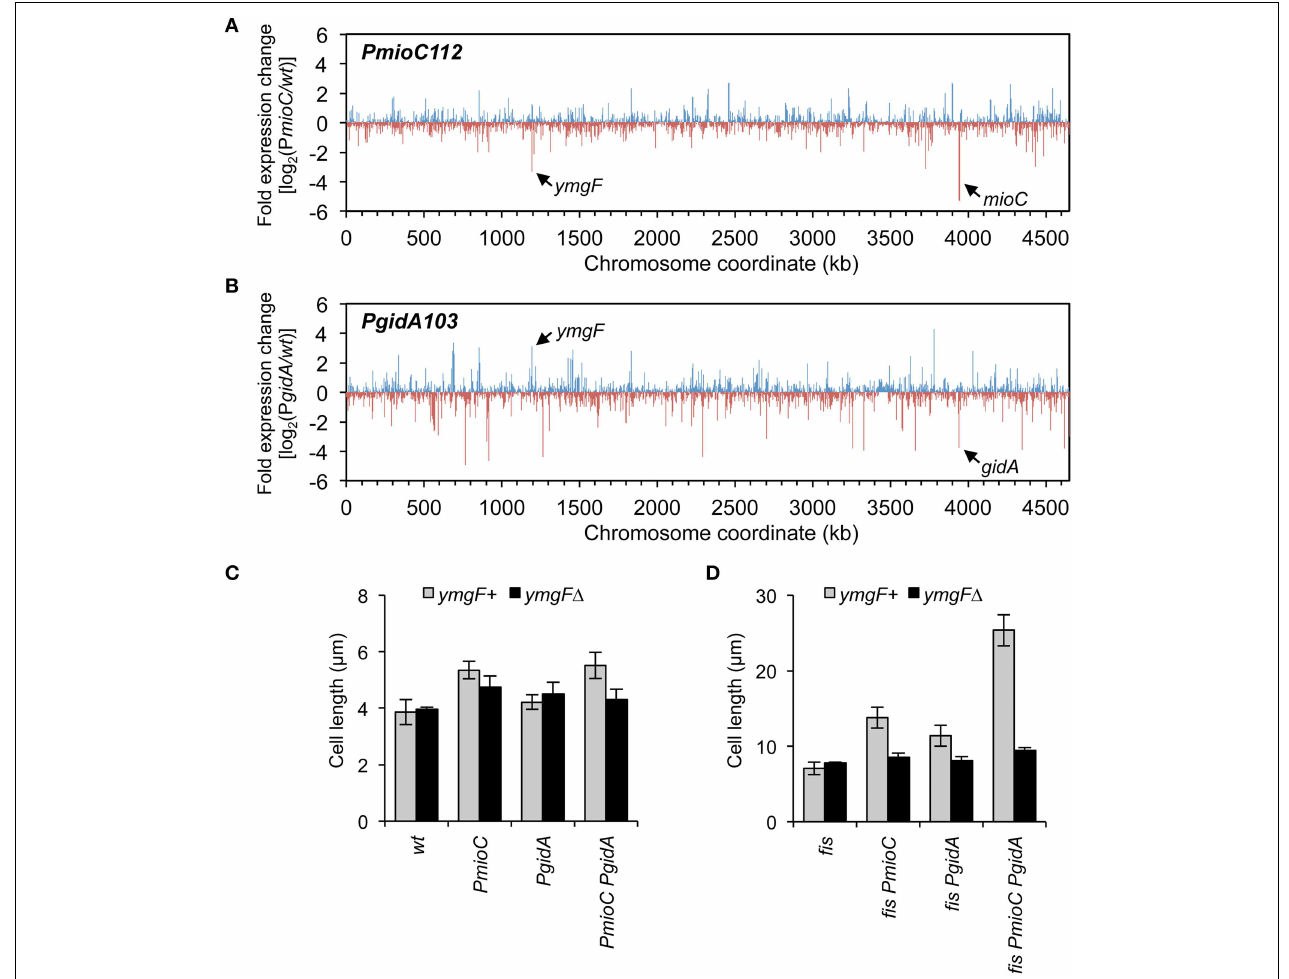
indicated. See Table S3 for description of other affected genes. (C,D) The cell elongation phenotype of gidA and mioC mutants requires YmgF. Cell length was measured in exponentially growing wildtype and mioC and gidA promoter mutants in fis + (C) or fis − (D) genetic background, in the presence (black bars) or absence (gray bars) of a ymgF 1